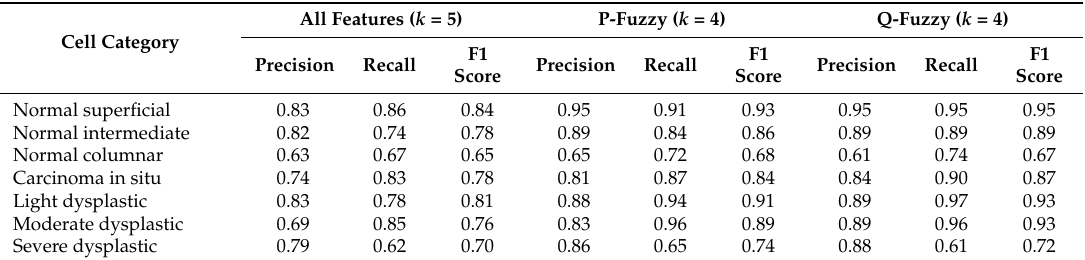
Table 6. Comparison of classification results with and without prior feature selection using the all-features, P-Fuzzy, and proposed Q-Fuzzy approaches.